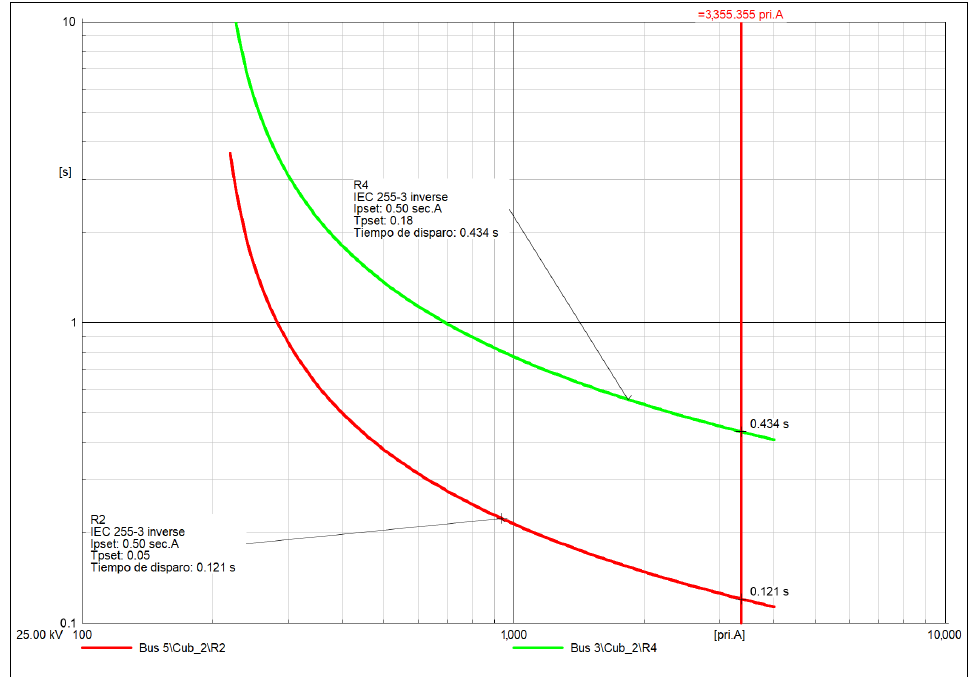
Figure 14. Coordination curve R4–R2 line fault DL-5 scenario